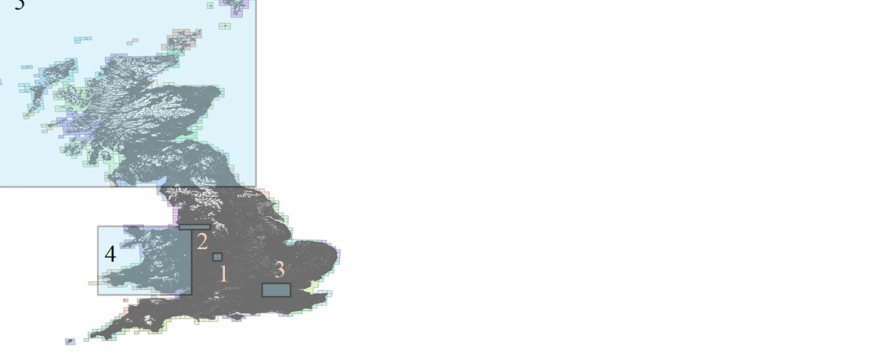
Figure 12. Dataset and rectangles used in the real experiment. The rectangles are numbered 1 to 5.